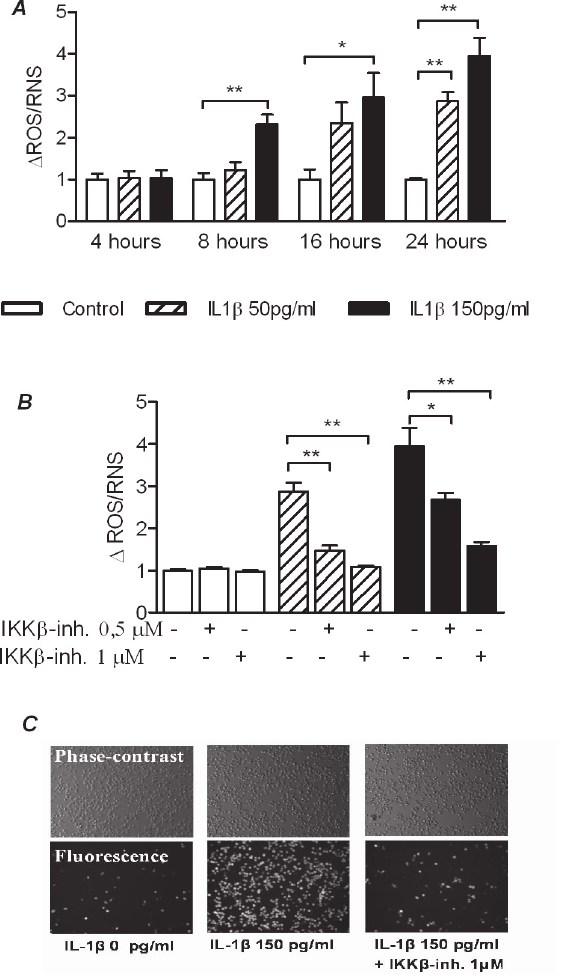
Figure 2. Prevention of IL-1 mediated ROS in INS-1 cells by an IKK b -inhibitor. A : ROS was measured in Krebs-Ringer bicarbonate buffer with 10 m M fluorescent probe CM-H2DCFDA (Molecular probes) following incubation of the cells with and without IL-1 b for 4, 8, 16 and 24 hours. Results are shown as delta fluorescence (t 90 min – t45 min). B : ROS was measured after 24 hours incubation in the presence or absence of IL-1 b and the IKK b -inhibitor. C : Microscopy of INS-1 after 24 hours incubation in the presence or absence of IL-1 b and the IKK b - inhibitor (magnification x10). Phase contrast (upper photos) and fluorescence (lower photos) after incubation with 10 m M fluorescent probe (CM-H 2 DCFDA). All data are shown as the mean 6 S.E.M. (*p , 0,05; **p , 0,01; ***p ,